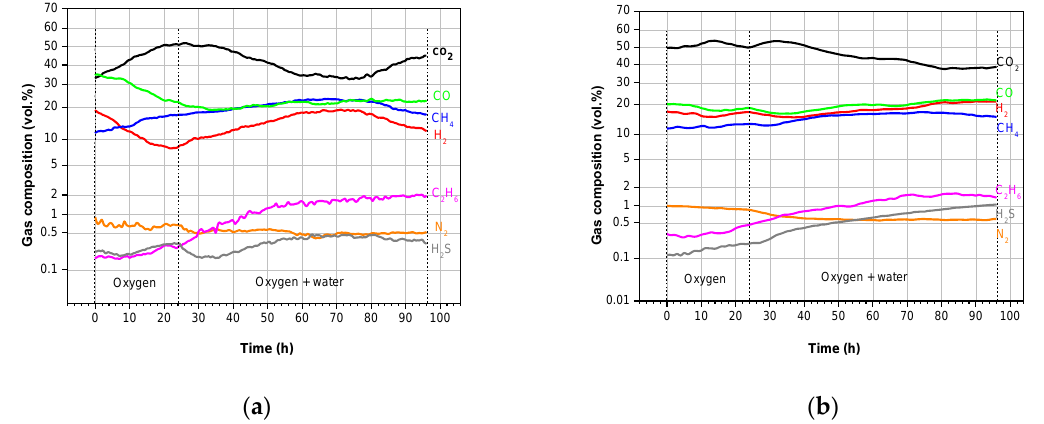
Figure 7. Changes in gas composition over the course of gasification experiments at 40 bar: ( a ) “Six Feet” semi-anthracite, ( b ) “Wesoła” hard coal. Table 4. Average gas compositions obtained during the four UCG experiments conducted. Gasification Experiment Average Process Gas Concentration, % vol.